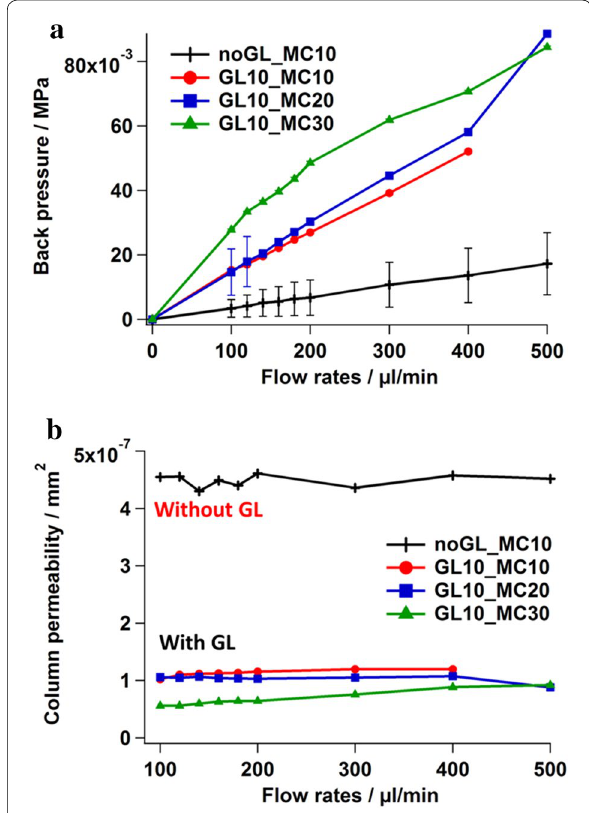
Fig. 5 Packing efficiency test of the poly(methyl acrylate) monolithic TPE column without and without the grafting layer, a back pressure and b column permeability as a function of the flow rate